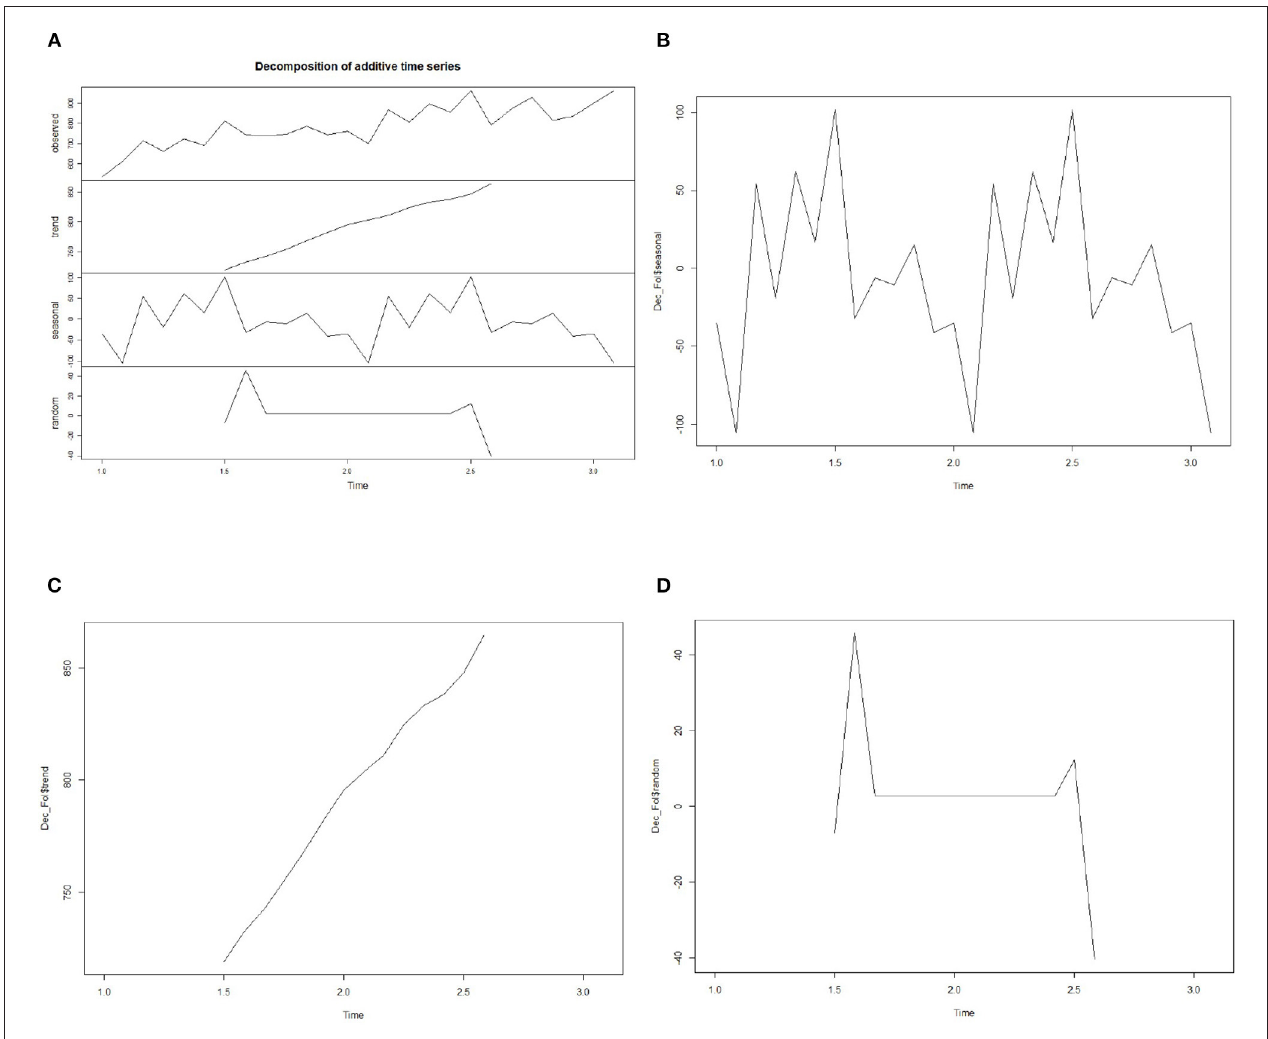
FIGURE 4 | Decomposed patient flow time series diagram. (A) decomposition of time series. (B–D) seasonal, trend and random section in time